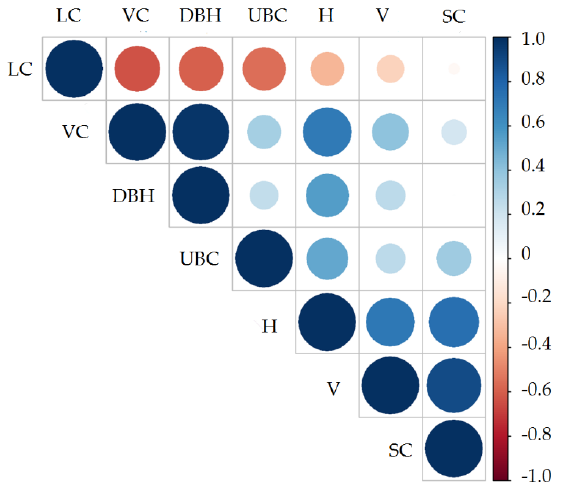
Figure 7. Relationship between carbon content in the stand, understory, and soil. Positive and neg- ative correlations are shown in blue and red, respectively. The color intensity and size of the circle are proportional to the correlation coefficients. Correlations with p -value > 0.05 are considered as non-significant and indicated by blank coefficient values. Here, LC: carbon storage of litter, VC: carbon storage of forest vegetation, DBH: diameter at breast height, UBC: carbon storage of